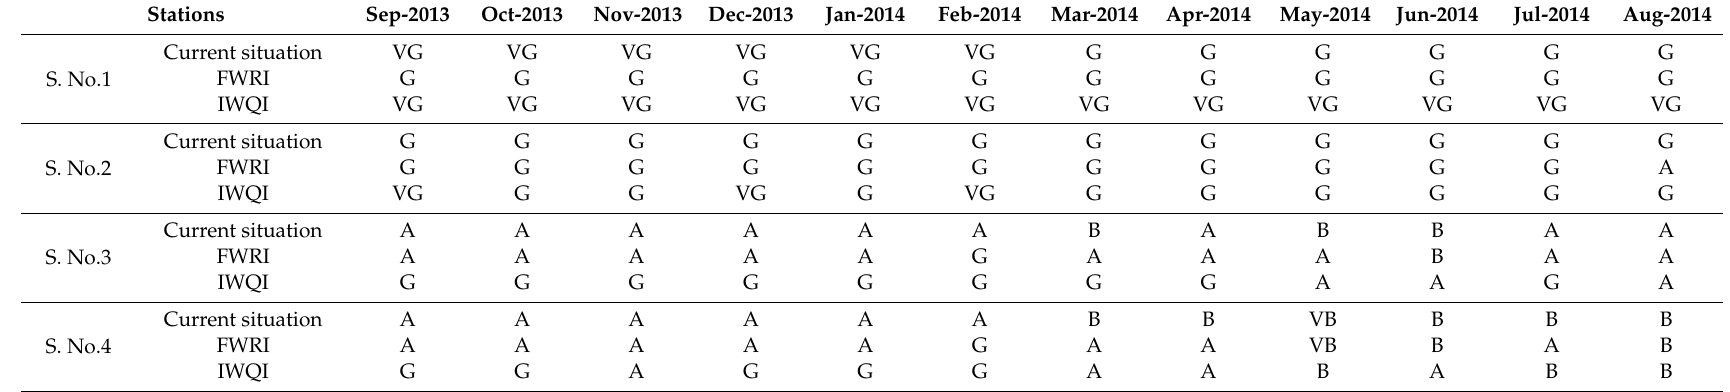
Table 9. Comparison of the o ffi cial current situation and the indices’ values at the four stations over the period from September 2013 to August